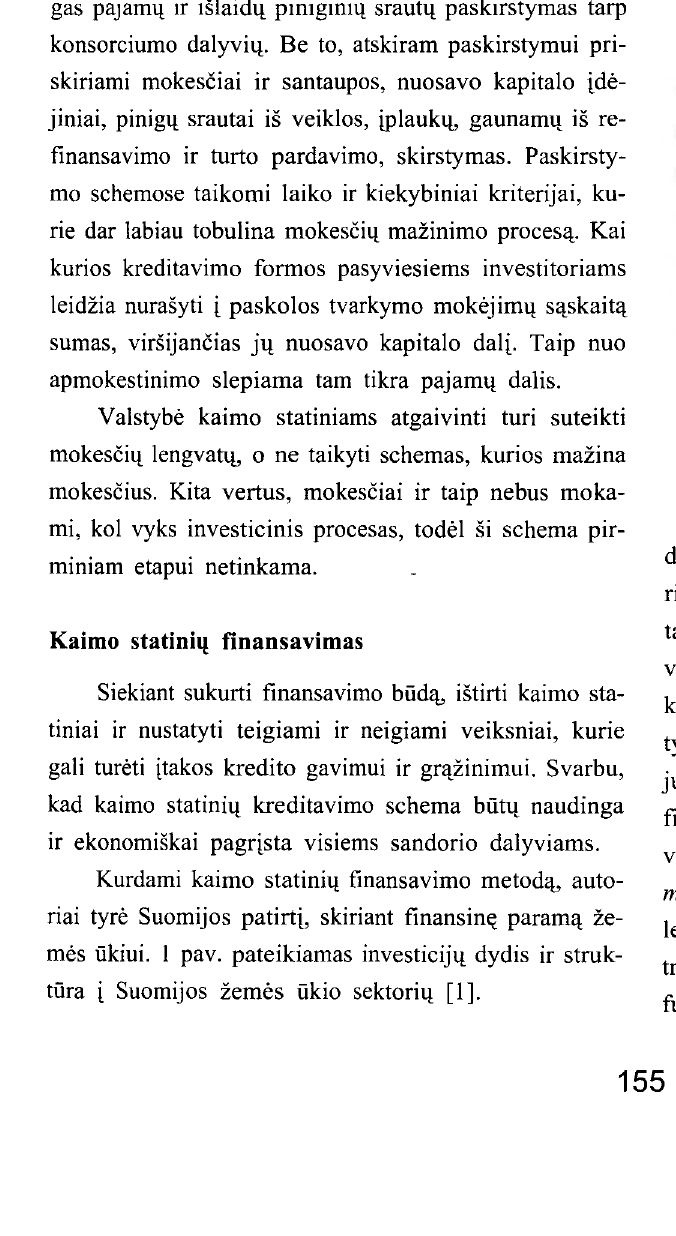
Fig 1. Investment in Finish agriculture (1980--1997) Kaip matome is I pav., daugiausia investicijq skirta mechanizmams ir irenginiams bei pastatams ir statiniams. Paprastai finansavimas vyksta per finansines instituci jas, bet dalis lesq gauta ir is valstybes (2 pav.) [2]. Suorri.jos